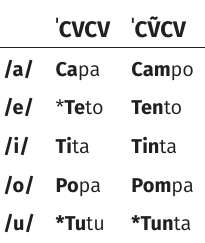
Table 1: Tokens recorded for stimulus